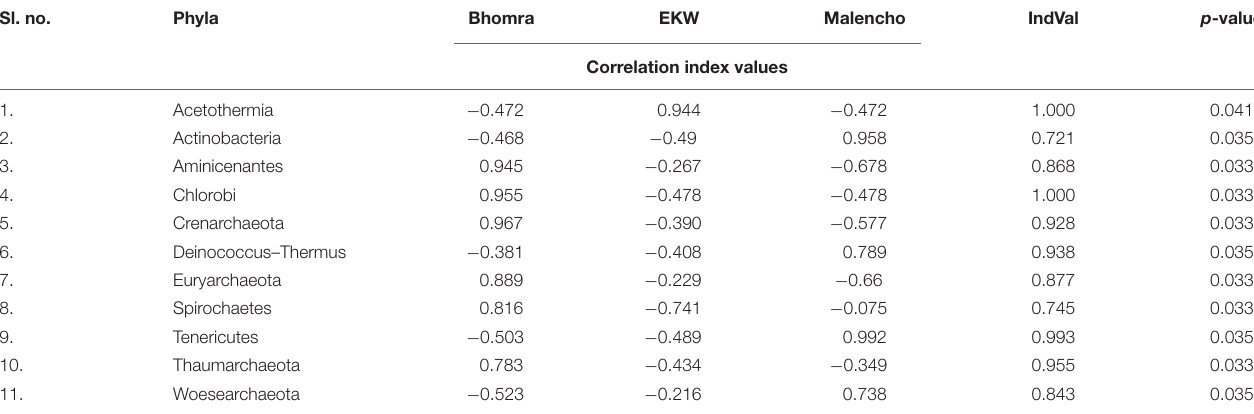
TABLE 2 | Phyla correlation index values and IndVal of different wetlands. Sl.